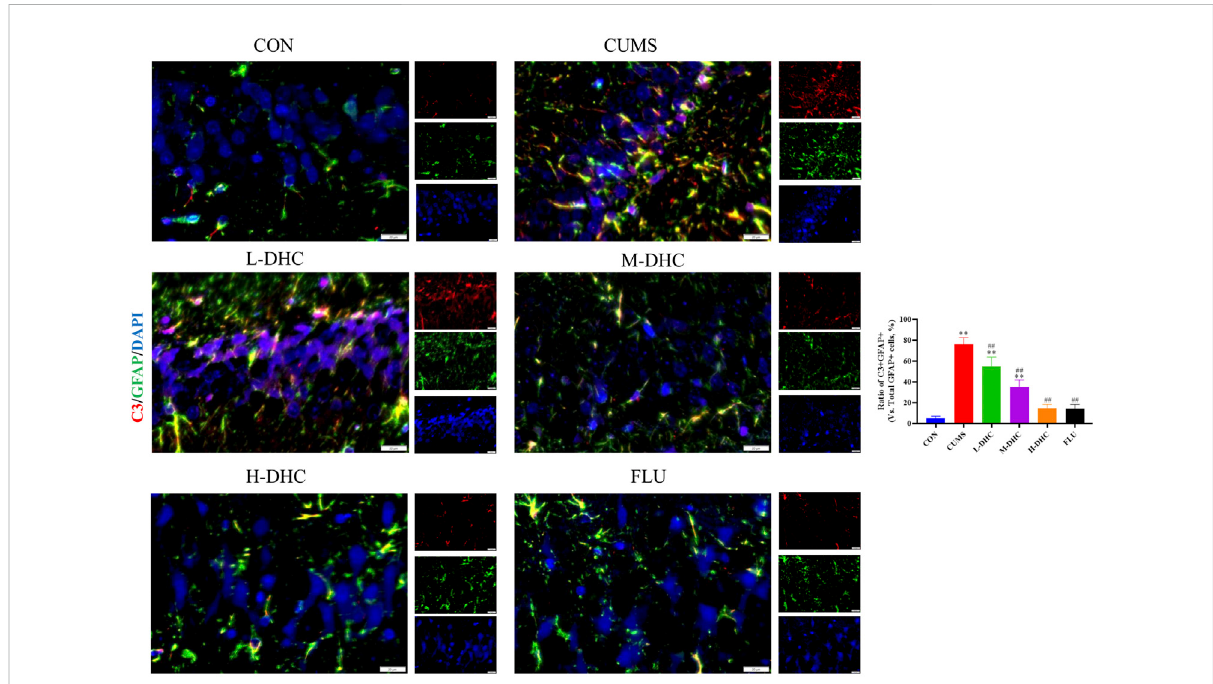
FIGURE 6 Effects of DHC or fl uoxetine on A1 astrocyte activation in CUMS-induced depression in mice. Red fl uorescence represented C3 positive cells andgreen fl uorescencerepresentedGFAPpositivecells. * p < 0.05and** p < 0.01,comparedwiththecontrol(CON)group; # p < 0.05and ## p < 0.01, compared with the CUMS